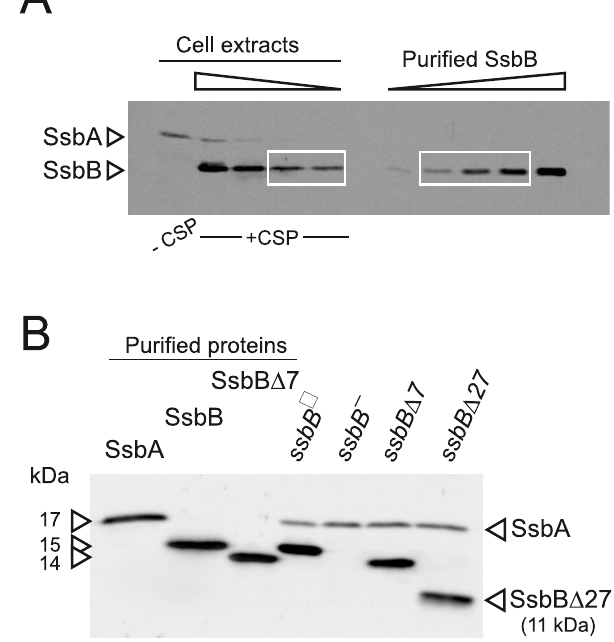
Figure 1. Western blot analysis of S.pneumoniae SsbA and SsbB proteins. (A) Quantification of SsbB in competent cells. For preparation of cell extracts, 20 ml culture in C + Y medium at OD 550 0.13 ( , 2.1 10 8 cfu ml 2 1 ) were divided into two equal parts, one of which received CSP (25 ng ml 2 1 ), and both were incubated for 12 min at 37 u C. Total cells were then collected by centrifugation. Western blotting was as described in Materials and Methods. Volumes of total cell extracts, from left to right: 20 m l ( 2 CSP) and 10, 5, 2.5 and 1.25 m l ( + CSP). Amounts of purified SsbB, from left to right: 3.1, 6.3, 12.5, 25 and 50 ng. White rectangles identify cell extract samples and the corresponding purified protein standards used for SsbB quantification. SsbB amounts calculated for 2.5 and 1.25 m l extracts were 30.0 and 14.9 ng, respectively, resulting in an estimate of 70,799 6 300 SsbB molecules per cell, considering a cell density in the culture of , 2.7 10 8 cells ml 2 1 (because , 30% of daugther cells remain attached to each other after completion of cell division; our unpublished observations). (B) Western- blot analysis of competent ssbB + , ssbB 2 , ssbB D 7 and ssbB D 27 cells. 5.3 m l of total extracts (corresponding to 235 m l culture at OD 550 0.15) were analyzed as described above. Strains used: R1501 ( ssbB + ), R2294 ( ssbB 2 ), R2081 ( ssbB D 7 ) and R2082 ( ssbB D 27 ). Purified S. pneumoniae SsbA (50 ng), SsbB (200 ng) and SsbB D 7 (200 ng) proteins were used as